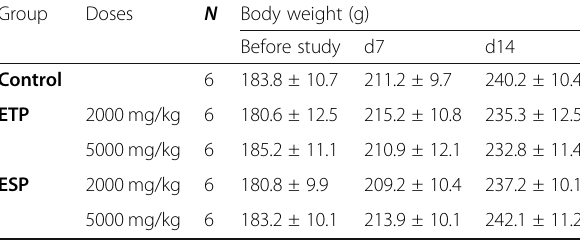
Table 5 Body weight changes of rats in acute toxicity